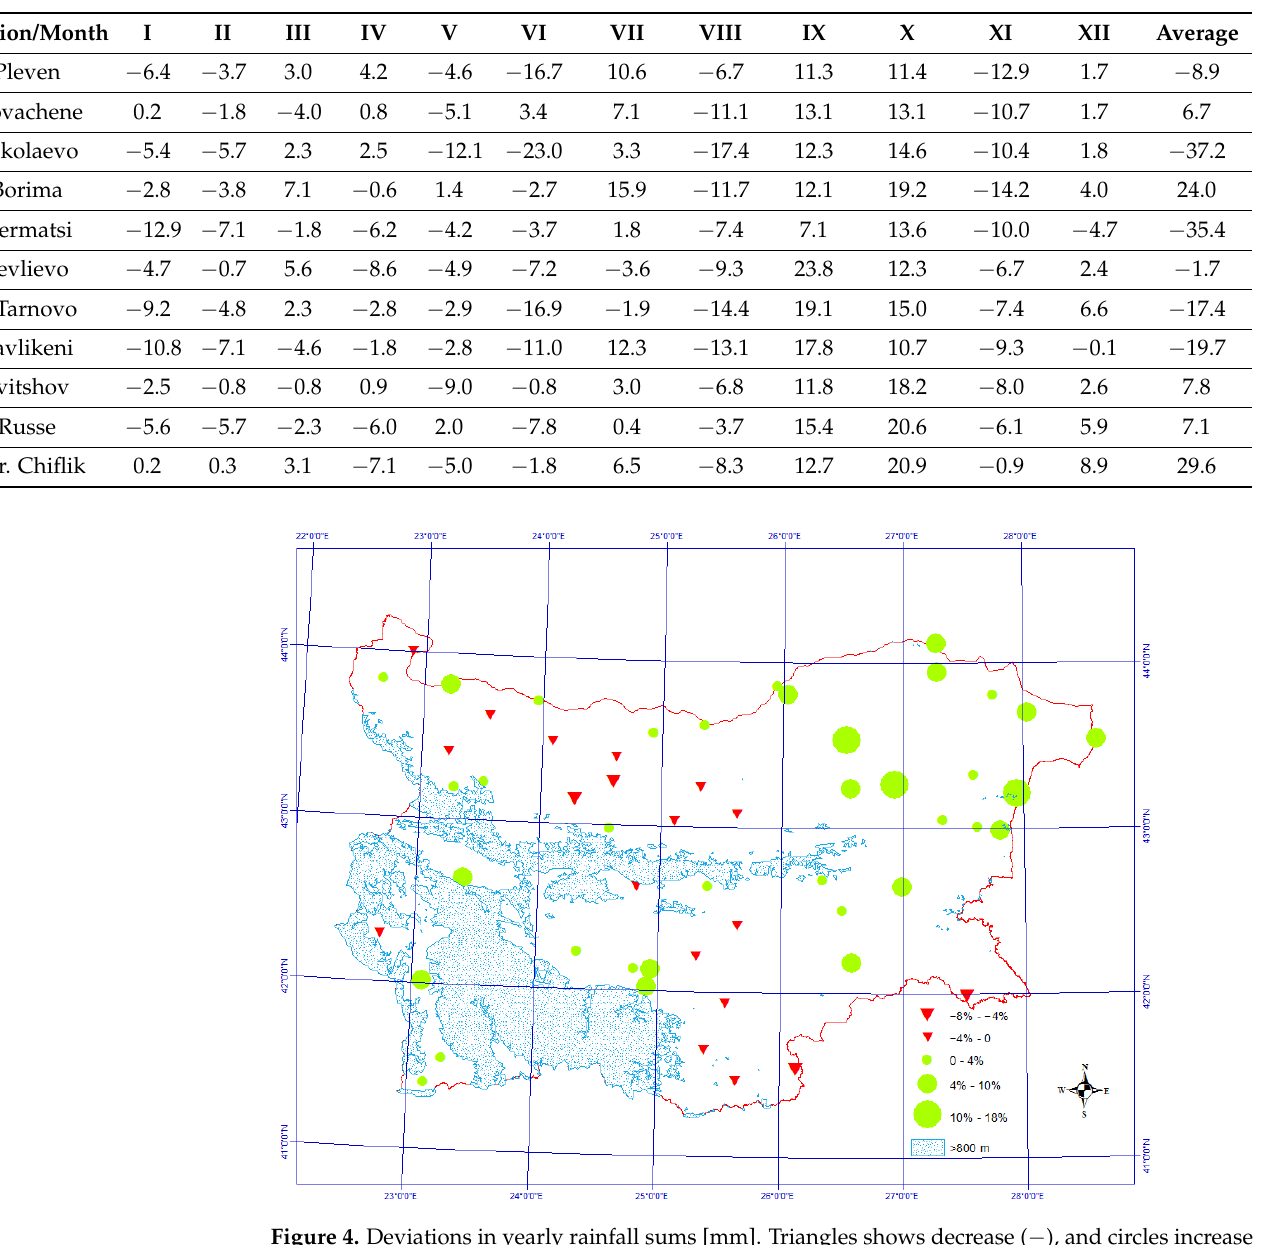
Table 13. Average monthly sums of rainfall deviations in central north Bulgaria in the period 1986–2015.